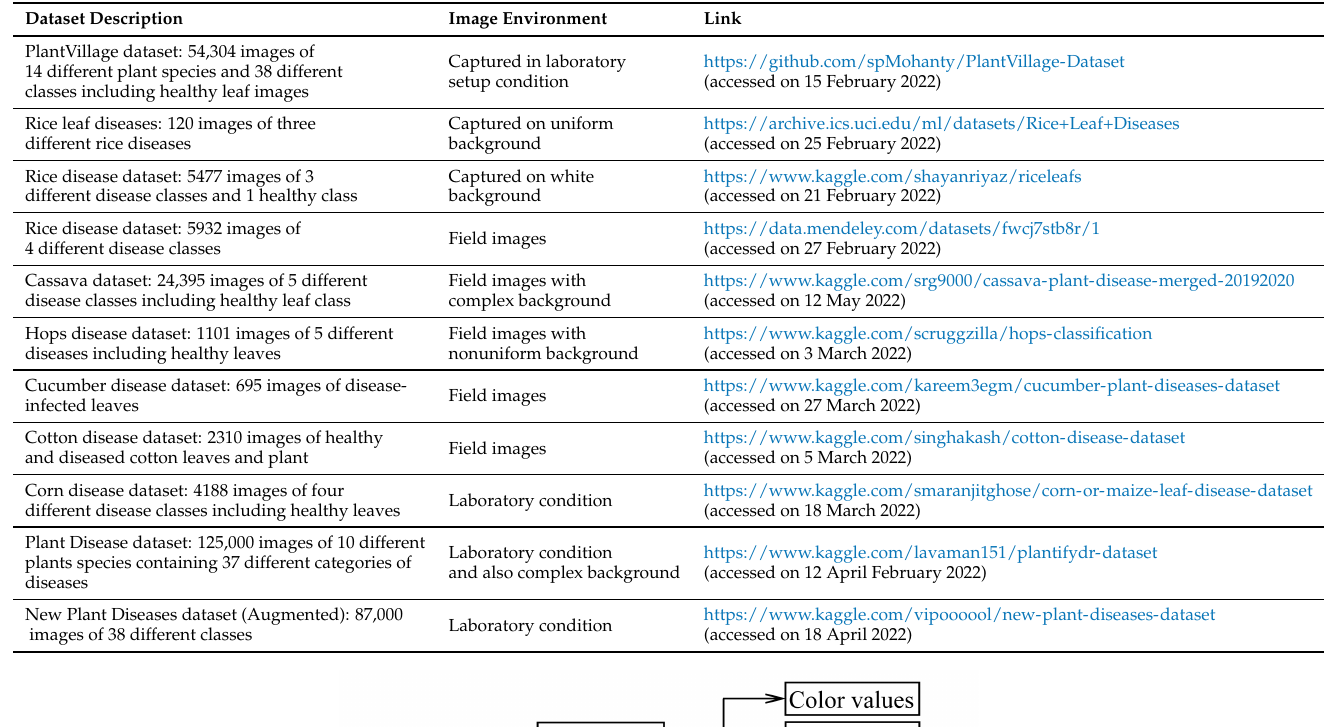
Table 1. Details of the datasets used.